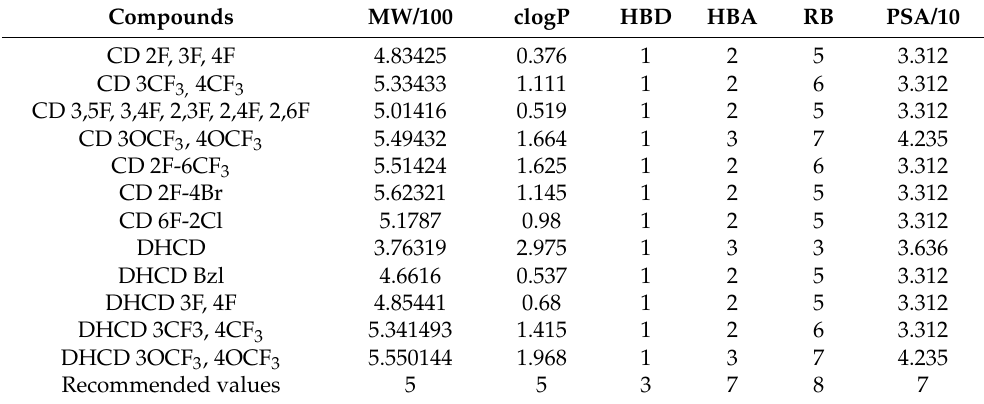
Table 5. Physicochemical properties (molecular weight (MW), partition coefficient (logP), hydrogen bonds donors (HBD), hydrogen bond acceptors (HBA), number of rotatable bonds (RB) and polar surface area (PSA)) of CD and DHCD compounds.